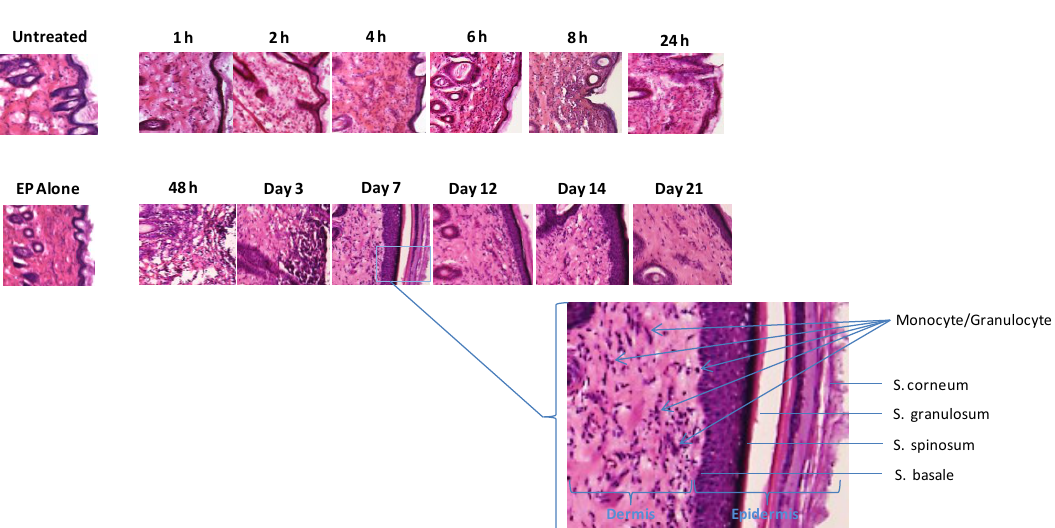
Figure 4. Rapid and persistent monocyte and granulocyte infiltration is detected at the treatment site following EP-enhanced plasmid delivery. Hematoxylin and eosin (H&E) stained histological analysis of skin sections following ID plasmid administration and EP with SEP in guinea pig skin in a time course. Skin biopsies were removed, cryosectioned, H&E stained and visualized under standard light microscopy (10×). An untreated control (no DNA, no EP) and EP alone post 1 h are also shown. A region of the day 7 time point section is enlarged to indicate skin structures and infiltration of monocyte and granulocyte.